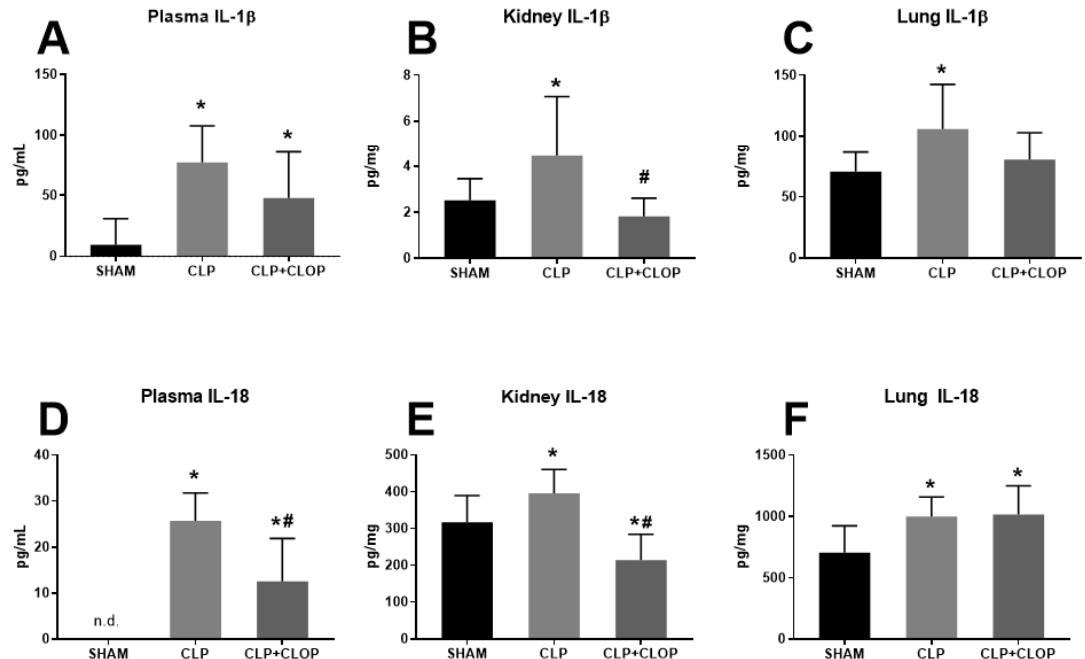
Figure 3. Inflammasome-associated cytokines. Plasma ( A , D ), kidney ( B , E ), and lung ( C , F ) IL-1 β and IL-18 were measured in Sham, CLP, and CLP rats treated with Clopidogrel ( n = 12/group) via ELISA. * p < 0.05 vs. Sham, # p < 0.05 vs. CLP, n.d. = not detected.